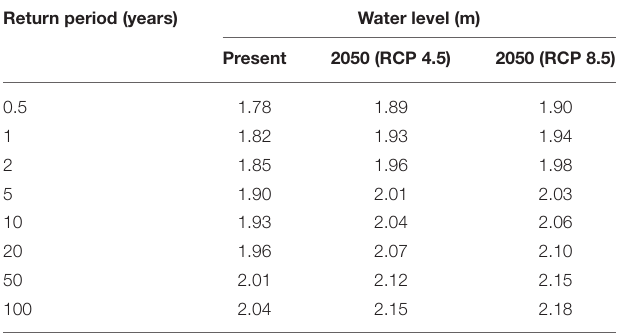
TABLE 3 | Water levels at Can Tho corresponding to different return period for Present, and for 2050 under RCP 4.5 and RCP 8.5.